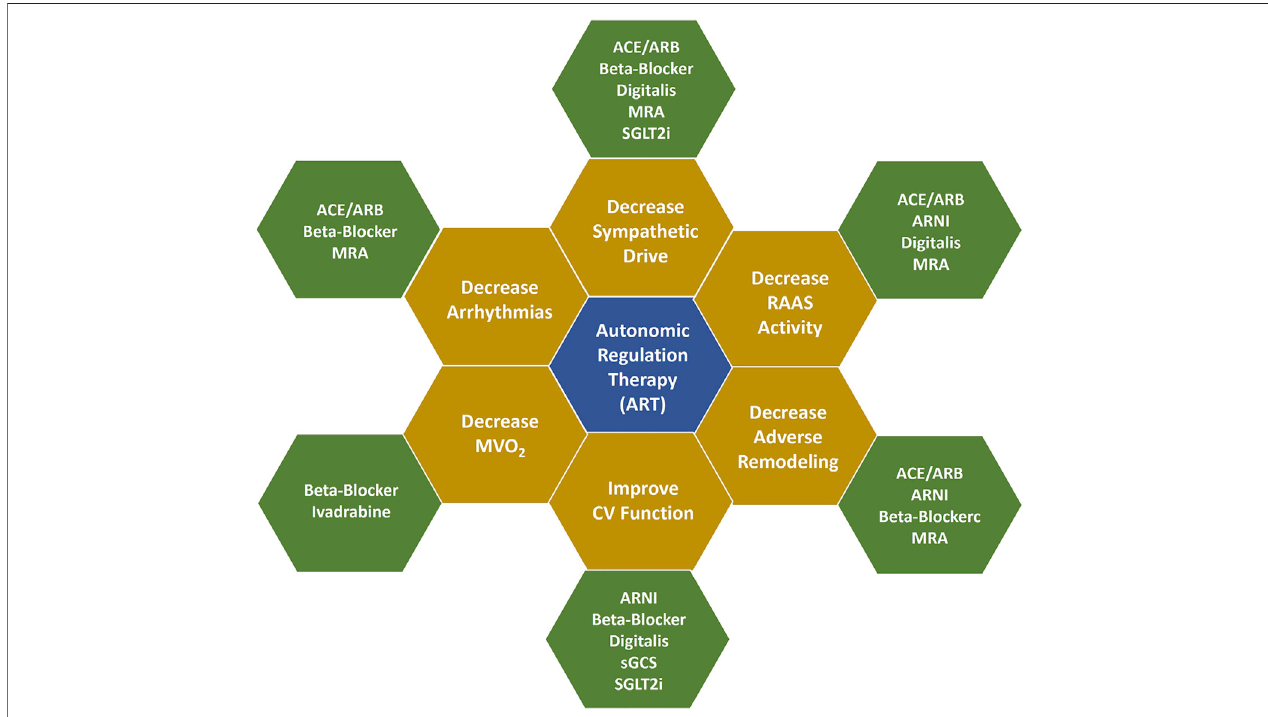
FIGURE 4 | Mechanisms of action of ART and GDMT. Figure adapted from Konstam MA, et al. Circ Heart Fail 2019 with permission. Additional information is provided in Supplementary Appendix S1, S2